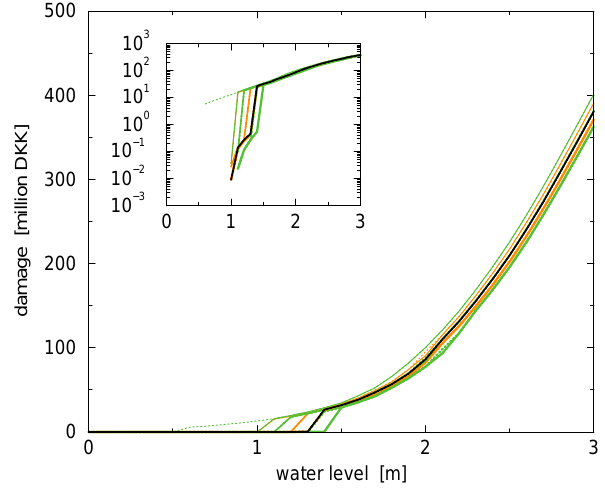
Fig. 5. Macroscopic damage function for different modes of in- undation determination. The estimated direct monetary damage is plotted against the water level for the following variations as de- tailed in Table 1 (top to bottom). (i) Considering 4 or 8 nearest neighbours is represented by a solid or dotted line. (ii) Coarse- graining in 2 × 2 cells or 3 × 3 cells is represented by orange or green (no coarse-graining: black). (iii) The width of the lines rep- resents the value associated to the coarse grained cells: minimum – thin, mean – medium, maximum – thick. A linear building damage function according to Eq. (1) has been used, see Fig. 2. The inset shows the same curves but in semi-logarithmic